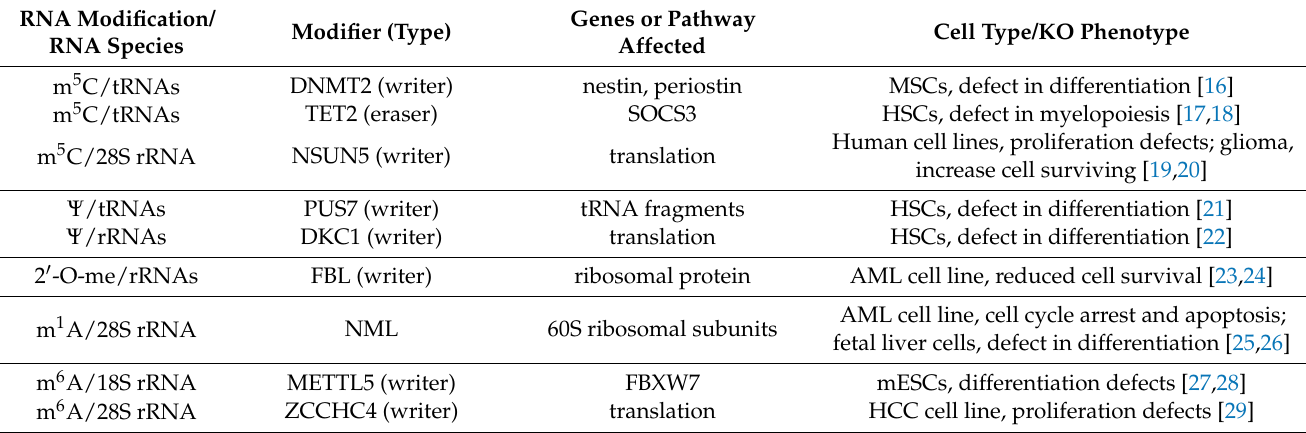
Table 1. Function of RNA modifications in tRNAs and rRNAs. RNA